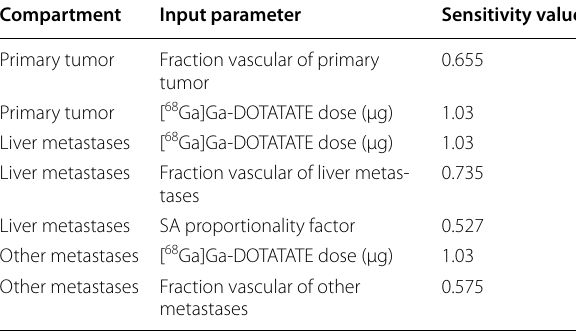
Only sensitivity values <